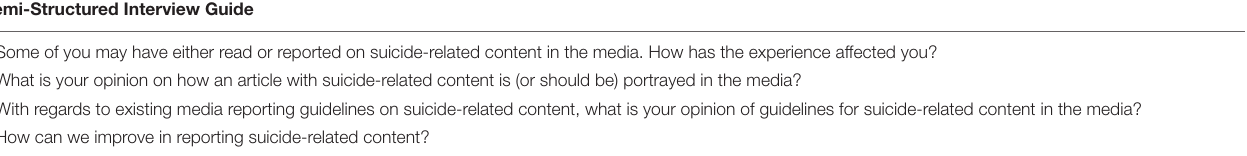
TABLE 2 | Participant